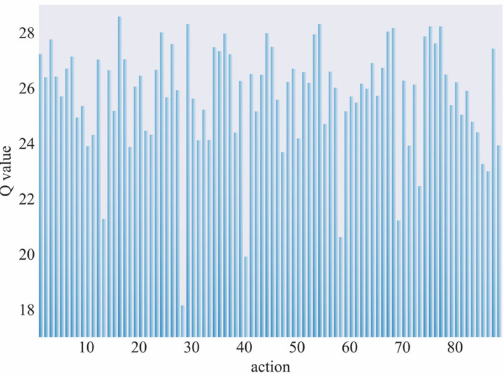
Figure 12. Q value of each action after the completion of scheme